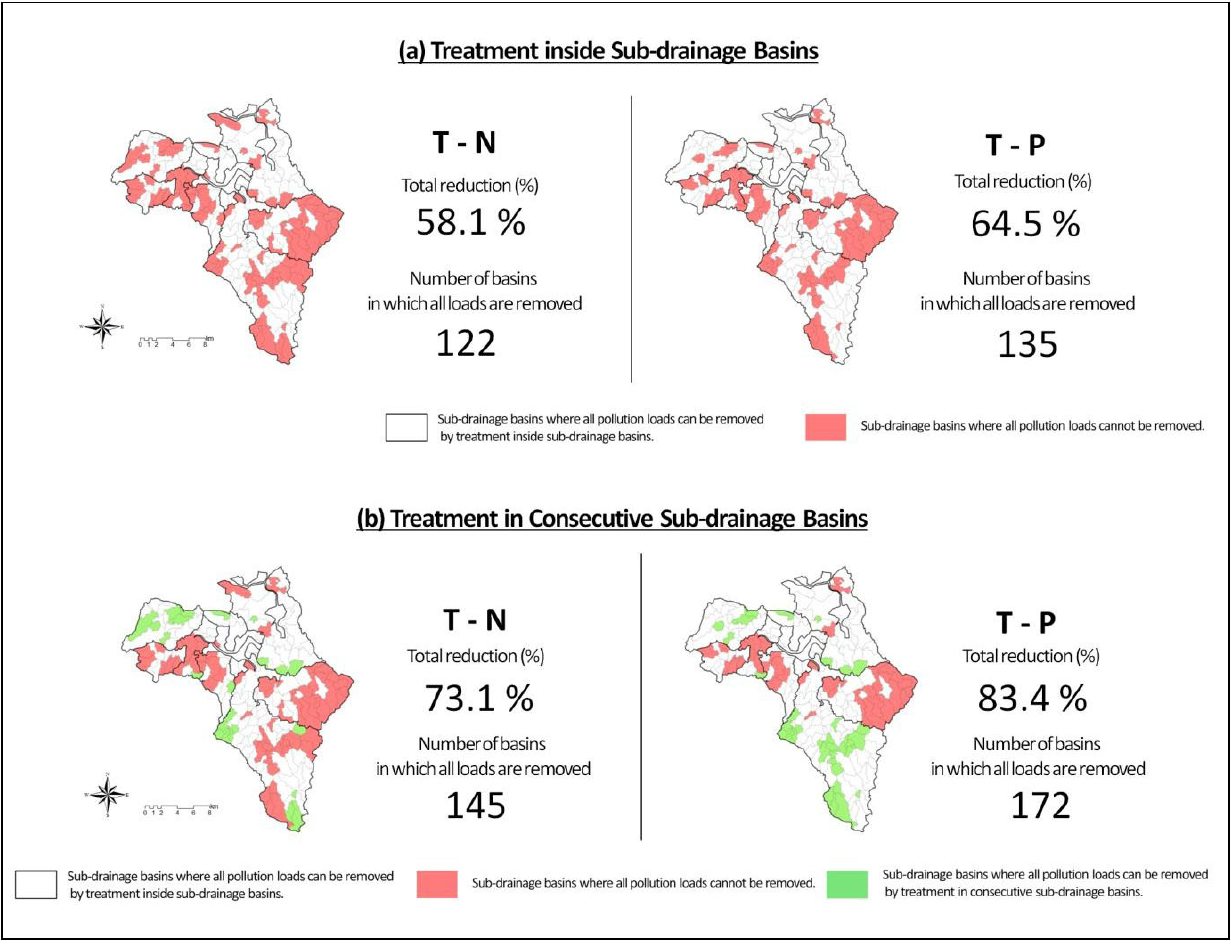
Figure 13. Pollution loads of T-N and T-P removed in abandoned paddy fields in the (a) ‘inside’ and (b) ‘consecutive’ drainage basin